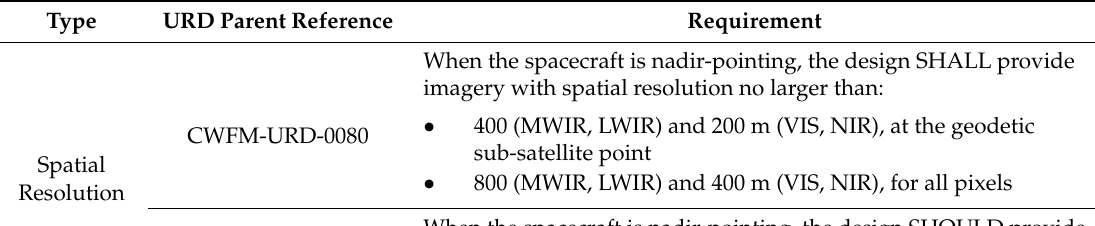
Table 5. Summary of key Measurement Requirements as outlined in the User Requirements Document (URD), and refined in the Mission Requirements for WildFireSat. TOA refers to Top of Atmosphere based on MODTRAN atmospheric